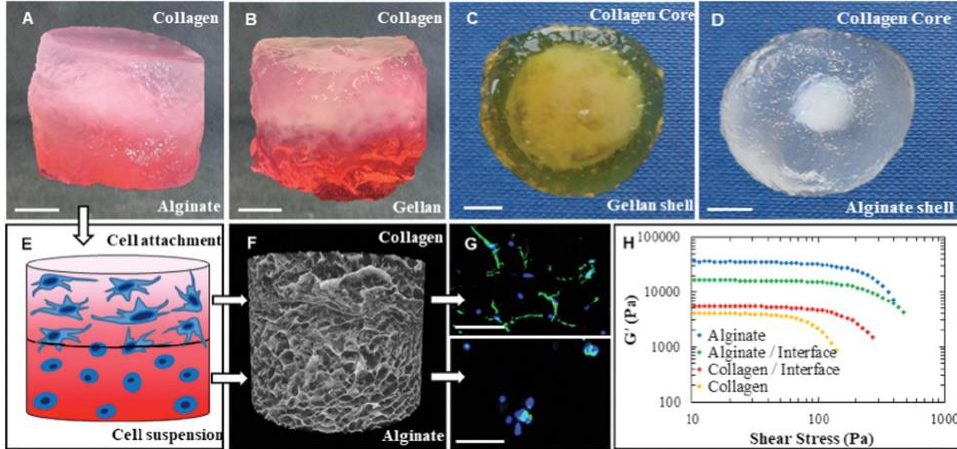
Figure 2. “3D printing multilayer gradient scaffolds by SLAM. ( A , B ) Images of bilayer scaffolds using combinations of ( A ) collagen–alginate and ( B ) collagen–gellan. ( C ) Large collagen–core gellan–shell scaffold and ( D ) small collagen–core alginate–shell scaffold (scale bars = 5 mm). ( E ) Schematic of diagram showing control of cell behavior with attachment motif bearing complexes in the upper collagen gel and no attachment motifs for cell suspension within an alginate gel. ( F ) Micro-CT showing gradient porosity within a lyophilized collagen–alginate scaffold. ( G ) Confocal micrographs of Hoechst/actin cell staining of HDFs attached in the collagen layer (upper) and suspended in the alginate (lower) regions of a dual layer scaffold (scale bars = 100 µm). ( H ) Stress versus G ′ showing variations in gel strength and elasticity across a collagen–alginate scaffold including the interfacial regions illustrating a gradient in mechanical strength across the printed part. ” [J. J. Senior, M. E. Cooke, L. M. Grover, and A. M. Smith, “Fabrication of Complex Hydrogel Structures Using Suspended Layer Additive Manufacturing (SLAM),” Adv. Funct. Mater., vol. 29, no. 49, p. 1904845, 2019. Reproduced with permission.].